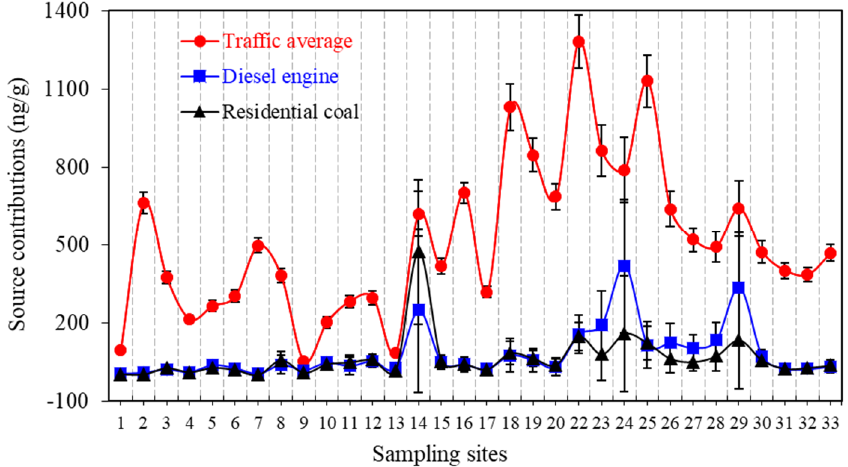
Figure 4. Contributions of each factor to total sediment PAH concentrations at each sampling site in Dalian Bay with error bars representing the standard deviation of the mean derived from the Monte Carlo uncertainty analysis.